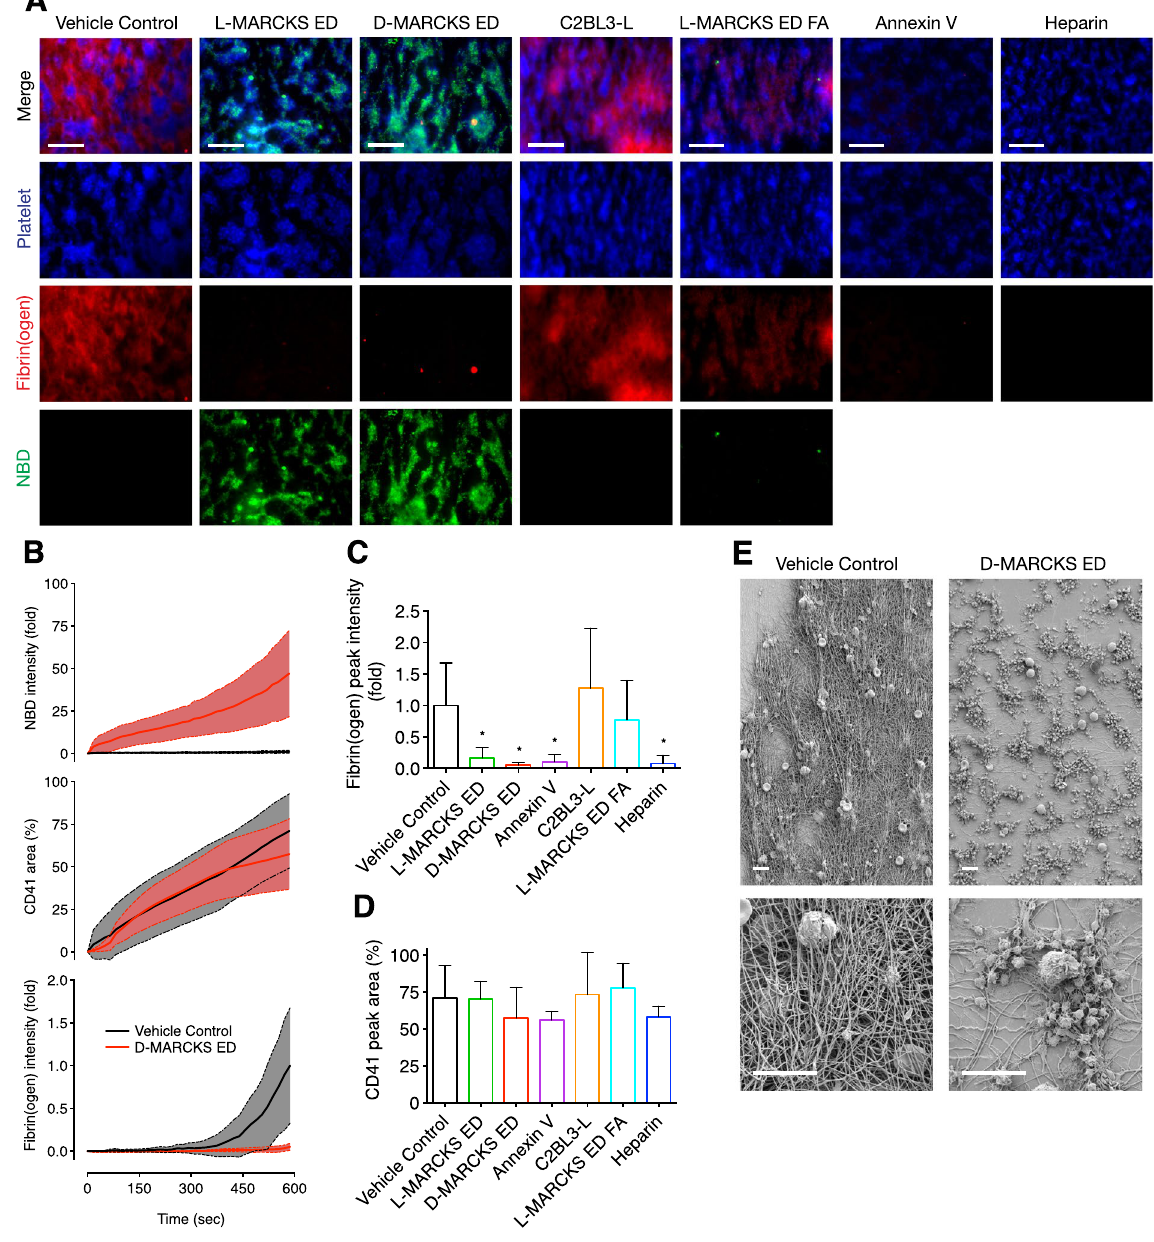
Figure 3. MARCKS ED inhibits fibrin formation in whole blood under physiologic flow conditions. ( A ) Representative images of platelet accumulation (blue, anti-CD41), fibrin(ogen) formation (red, Alexa Flour 647-fibrinogen), and peptide binding (green, NBD-peptide) in the whole blood microfluidic flow assay after 10 min at wall shear rate 100 s − 1 when pre-treated with vehicle control or 1 μ M L-MARCKS ED, D-MARCKS ED, negative control C2BL3-L, negative control L-MARCKS ED FA mutant, positive control annexin V, or positive control 15 USP ml − 1 heparin ( n = 6). Scale bar, 50 μ m. ( B ) Time course of peptide NBD fluorescence intensity, platelet surface area coverage, and fibrin(ogen) intensity for the vehicle control and D-MARCKS ED treatment in the microfluidic flow assay ( n = 6, mean ± SD). ( C ) Final fibrin(ogen) intensity values for each treatment in the microfluidic flow assay ( n = 6, mean ± SD). ( D ) Final platelet surface coverage values for each treatment in the microfluidic flow assay ( n = 6, mean ± SD). ( E ) Representative scanning electron micrographs of finals clots formed in microfluidic flow assay with vehicle control and D-MARCKS ED treatment ( n = 3). Scale bar, 10 μ m. * P < 0.05 compared to vehicle control by ANOVA followed by Dunnet’s post hoc test ( C , D D-MARCKS ED binds to thrombi in vivo . To assess the in vivo localization of D-MARCKS ED, as well as its effects on the hemostatic response, we used a murine intravital laser-induced microvascular injury model 35 . Male mice were treated with 5 mg kg − 1 C2BL3-L or D-MARCKS ED through a jugular vein cannula. 30 min later, fibrin